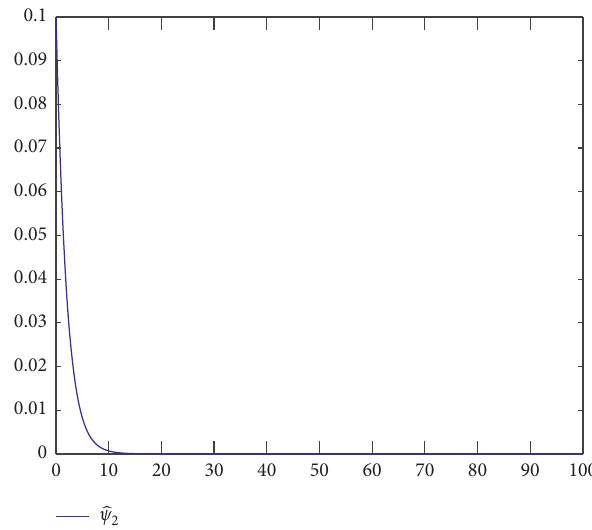
Figure 5: The response of the adaptive rate 􏽢 ψ